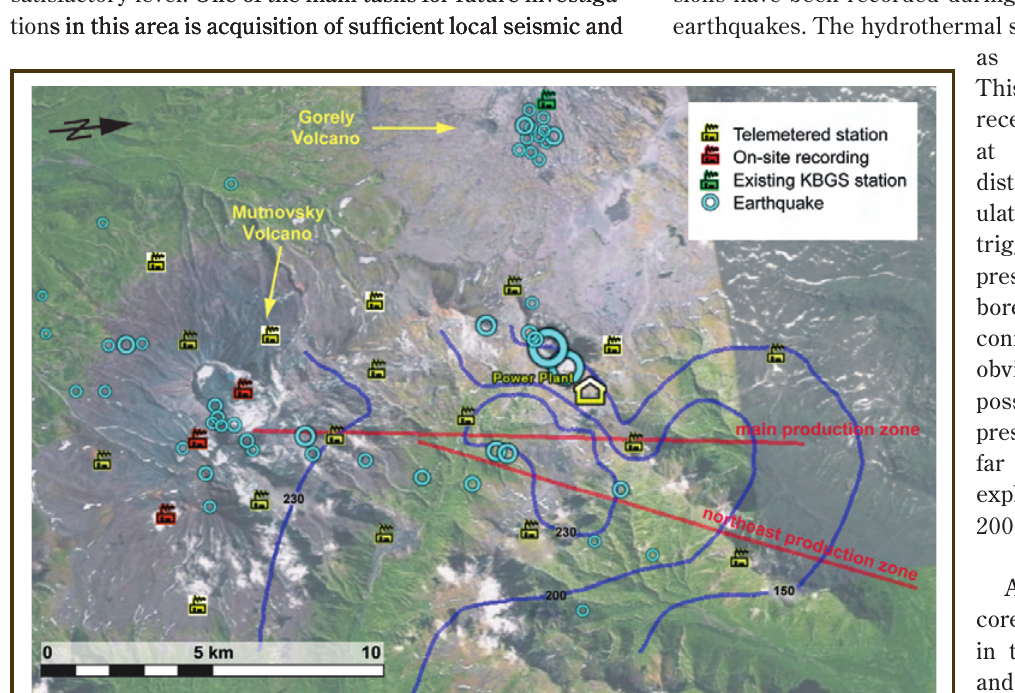
Figure 6. Proposed 20-station real-time seismic network at Mutnovsky Volcano and geothermal field. Earth- quake epicenters (2001–2005) range in magnitude from Ml=1.8 to 3.8. Red lines mark the high permeability planes where production wells are located. Blue lines mark geothermal contours at 250 mbsl (from Kiryukhin et al., 1998). Earthquake data are from the Kamchatka Branch of the Geophysical Service (KBGS), and the base photo is from Google